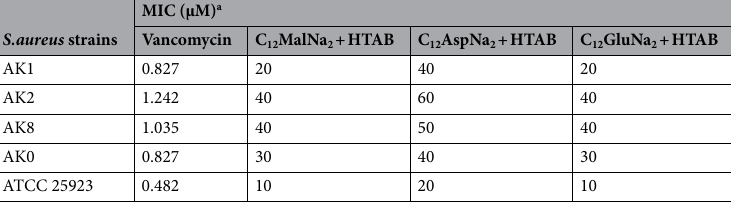
Table 1. Antibacterial activities of AAS + HTAB gels against S. aureus clinical isolates. a For the determination of MIC value, serial concentrations in the range of 5 to 100 µM (with an increment of 5 μM in each step) of each surfactant mixture was applied to bacterial culture containing 1 × 10 7 CFU. Data represent mean values of three experimental